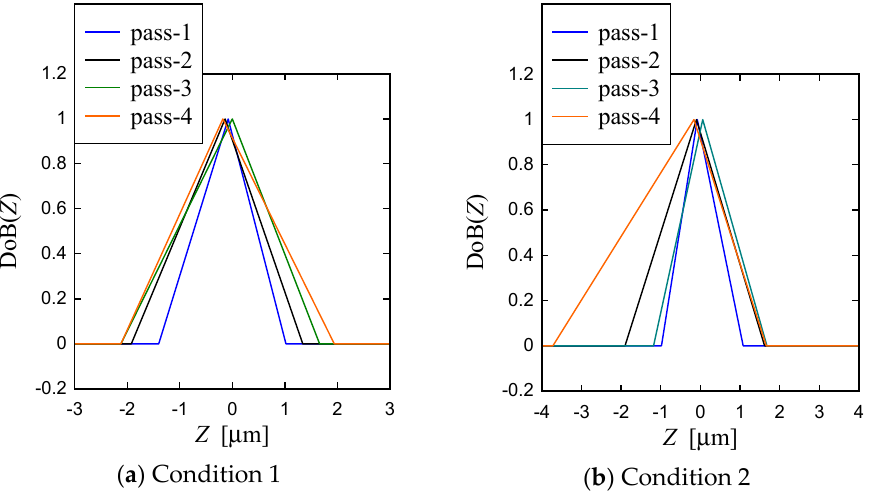
Figure 14. Possibility distributions of the surface heights of ground surface due to multiple passes.